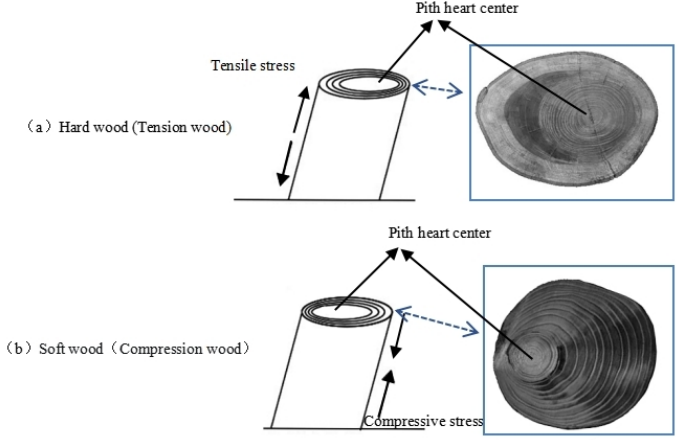
Figure 2. Eccentric growth of a stem related to the occurrence of ( a ) tension wood and ( b ) compression wood [22].